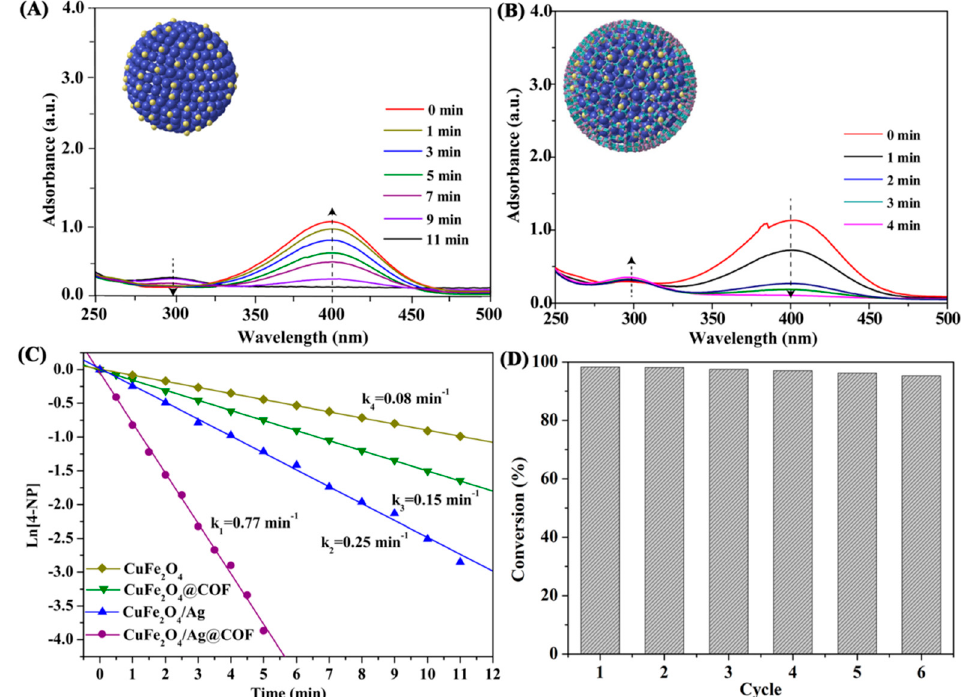
Figure 6. ( A ) Typical time-dependent evolution of ultraviolet-visible (UV-Vis) spectra for the catalytic reduction of 4-nitrophenol (4-NP) to p -animophenol (4-AP) by CuFe 2 O 4 / Ag; ( B ) typical time-dependent evolution of UV-Vis spectra for the catalytic reduction of 4-NP to 4-AP by CuFe 2 O 4 / Ag@COF; ( C ) relationship of the ln[4-NP] and the reaction time t for the reduction of 4-NP to 4-AP over CuFe 2 O 4 , CuFe 2 O 4 @COF, CuFe 2 O 4 / Ag and CuFe 2 O 4 / Ag@COF; ( D ) the reusability of CuFe 2 O 4 / Ag@COF for the reduction of 4-NP by NaBH 4 .